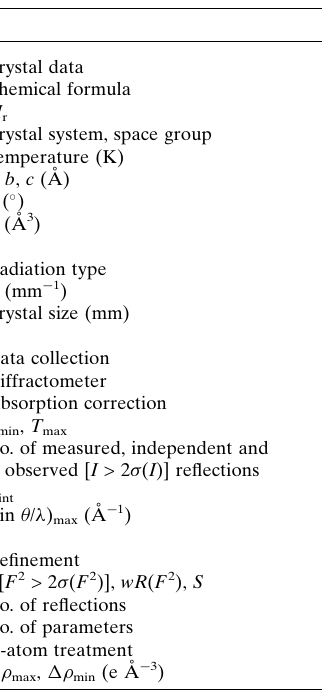
Table 3 Experimental details.